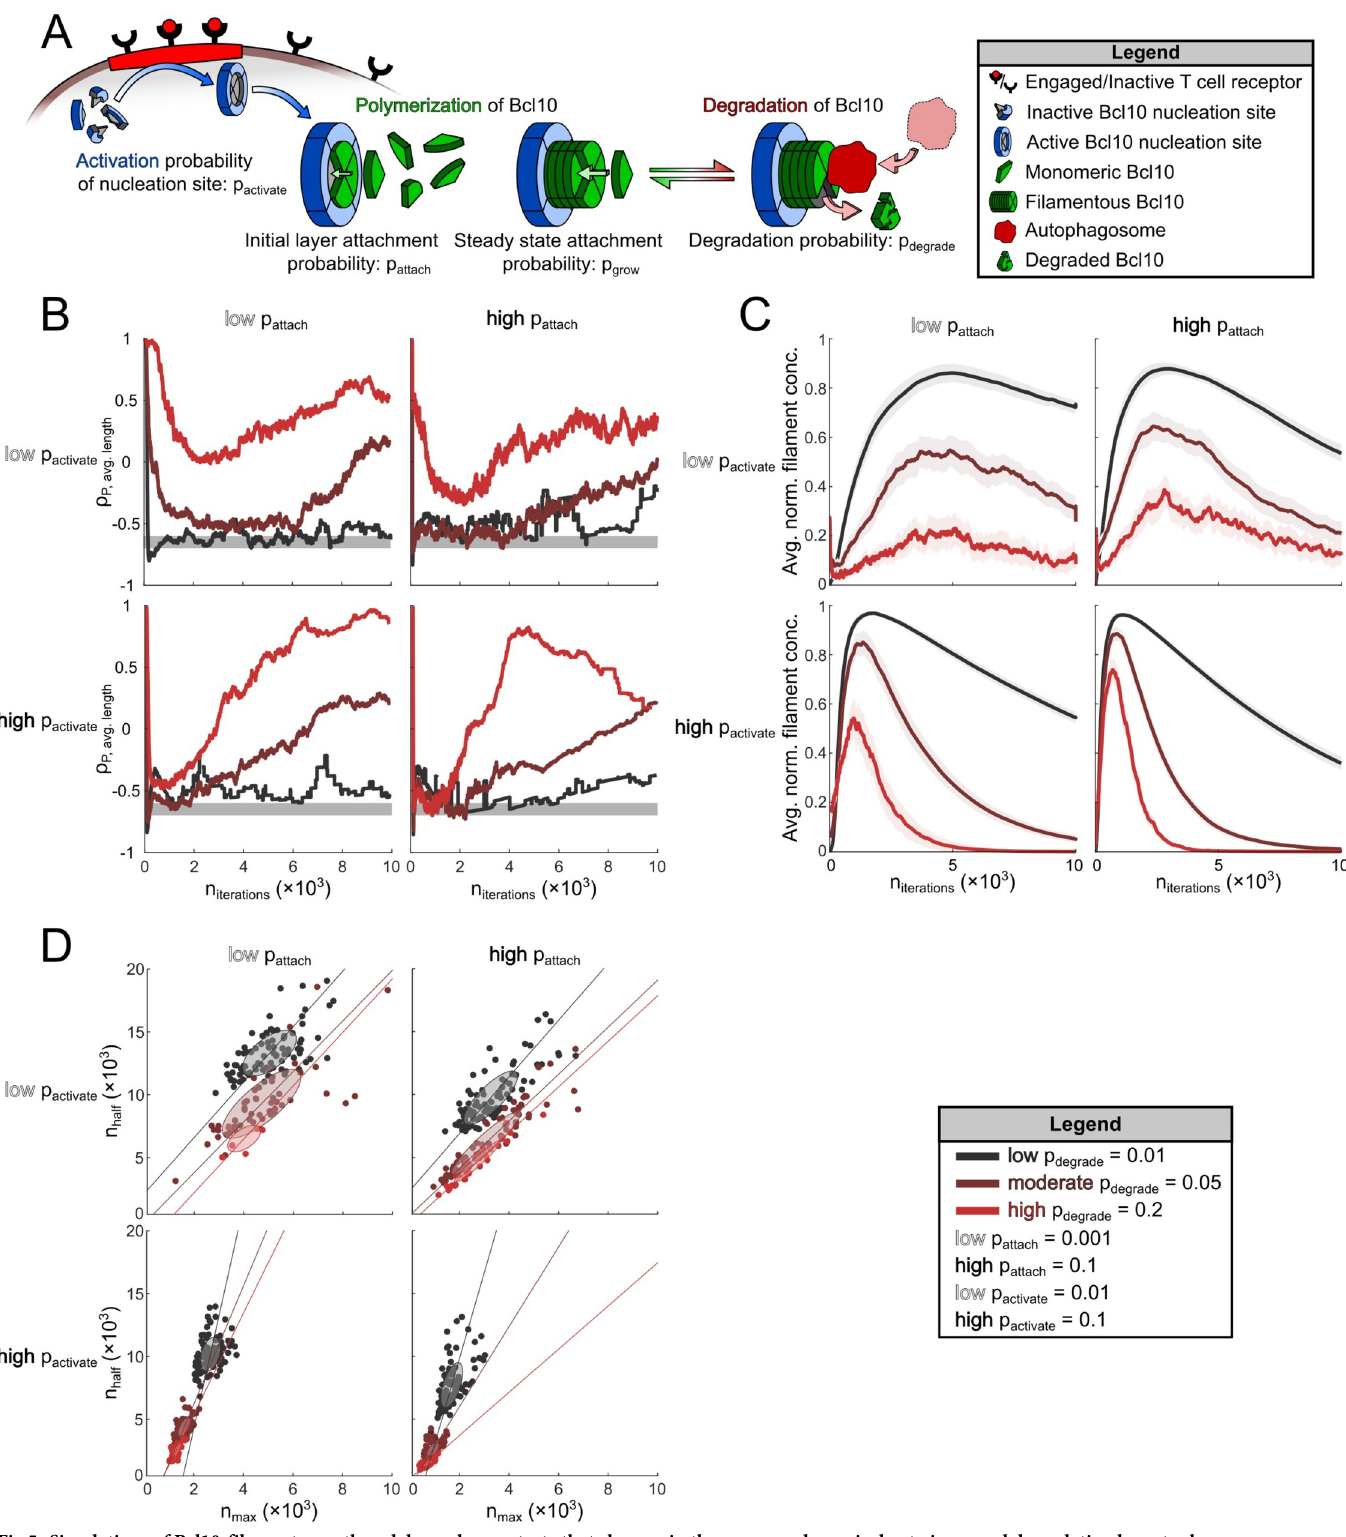
Fig 5. Simulations of Bcl10-filament growth and decay demonstrate that changes in the response dynamic due to increased degradation by autophagy were stabilized by increased p attach but emphasized by increased p activate . (A) Bcl10-filament degradation was simulated in conjunction with filament growth. Degradation